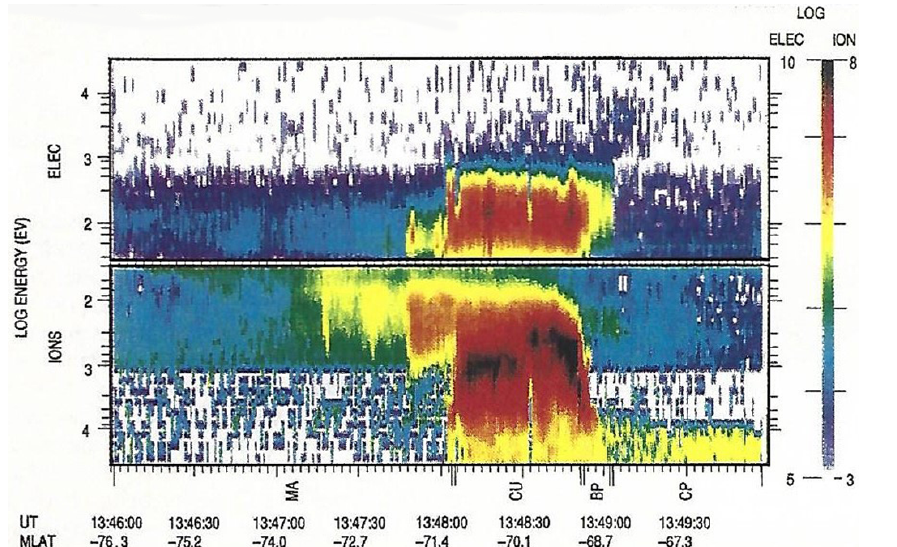
Figure 7. Energy–time spectrograms of electrons and ions obtained on 10 October 1988 by the Defense Meteorological Satellite Program (DMSP) F9 spacecraft. The large ticks on the time axis bound the magnetospheric regions that are associated with the particle spectra that were observed. These regions are as follows: MA – mantle; CU – cusp; BP – boundary plasma layer; CP – central plasma sheet. Note that the spacecraft was detecting the cusp from 13:48:05–13:48:54UTC (universal coordinated time). Reproduced from Fig. 1b of Baker et al.